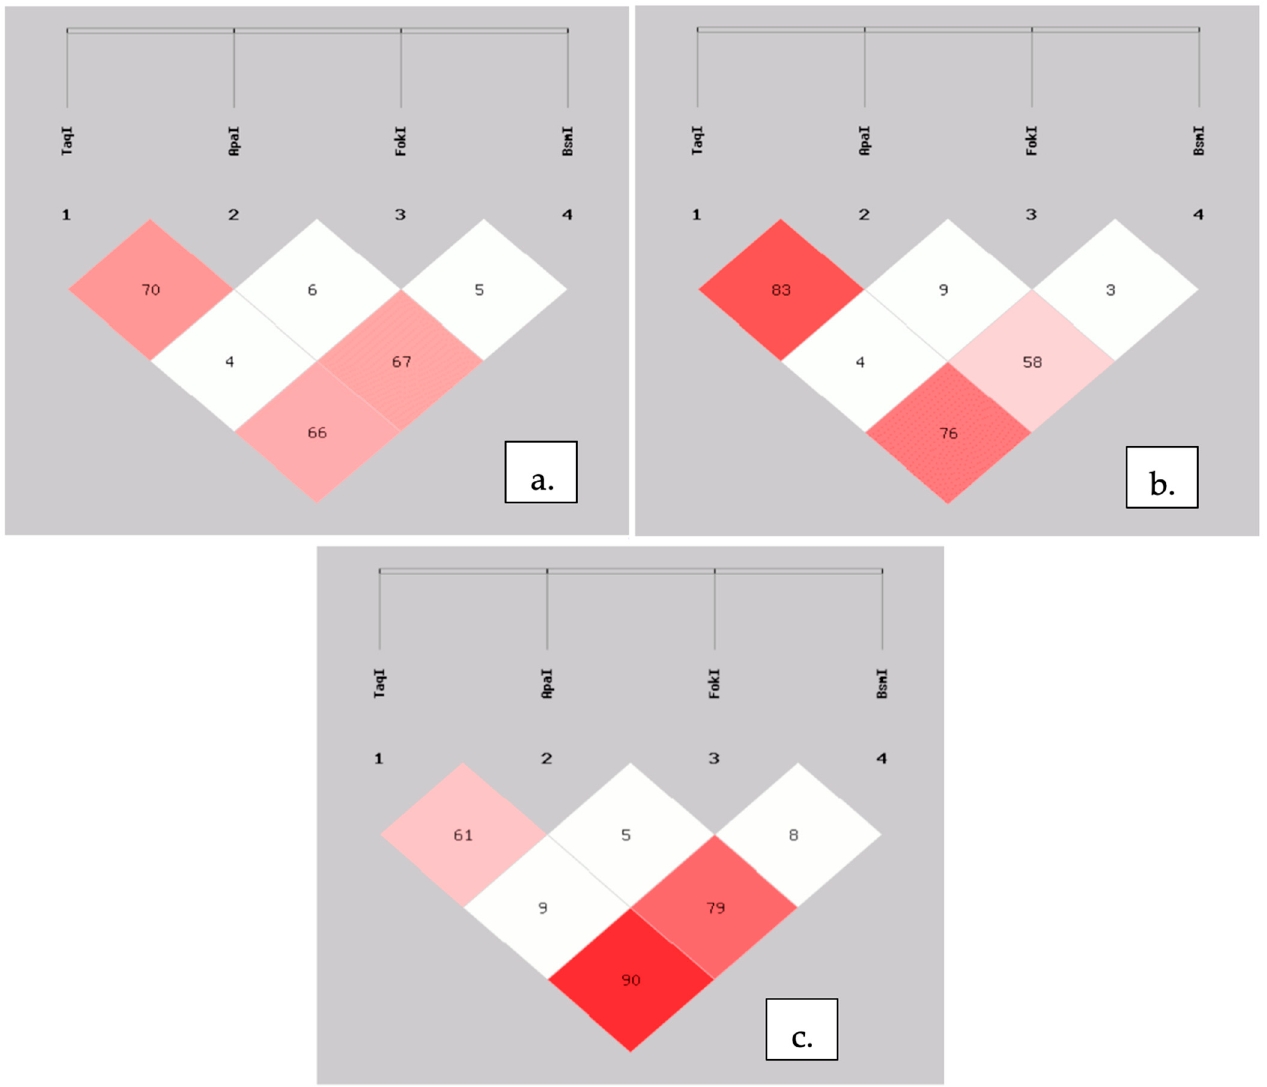
Figure 3. Linkage disequilibrium plots for four investigated SNPs for both groups ( a ), controls ( b ), and CRC patients ( c ). The number represents the percentage value of ‘D, which is also indicated by color intensity.